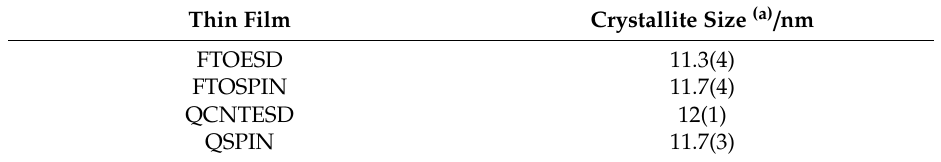
Table 2. Crystallite size of the anatase crystals in the heat-treated thin films on two different glass substrates prepared via the ESD and spin-coating processes, FTOESD, FTOSPIN, QCNTESD, and QSPIN.